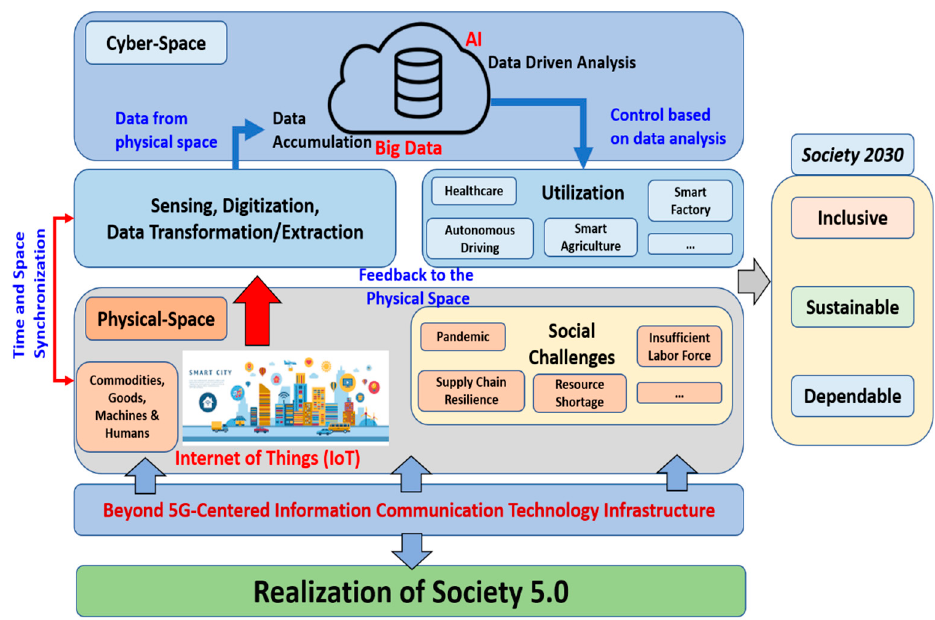
Figure 20. Progress of cyber physical system and society in the 2030s (adapted from [77]).